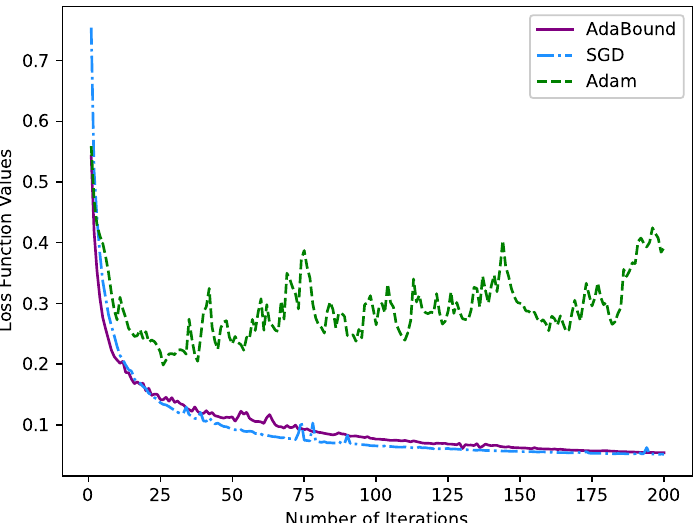
Figure 12. The novel loss function curve under different optimizers with the number of